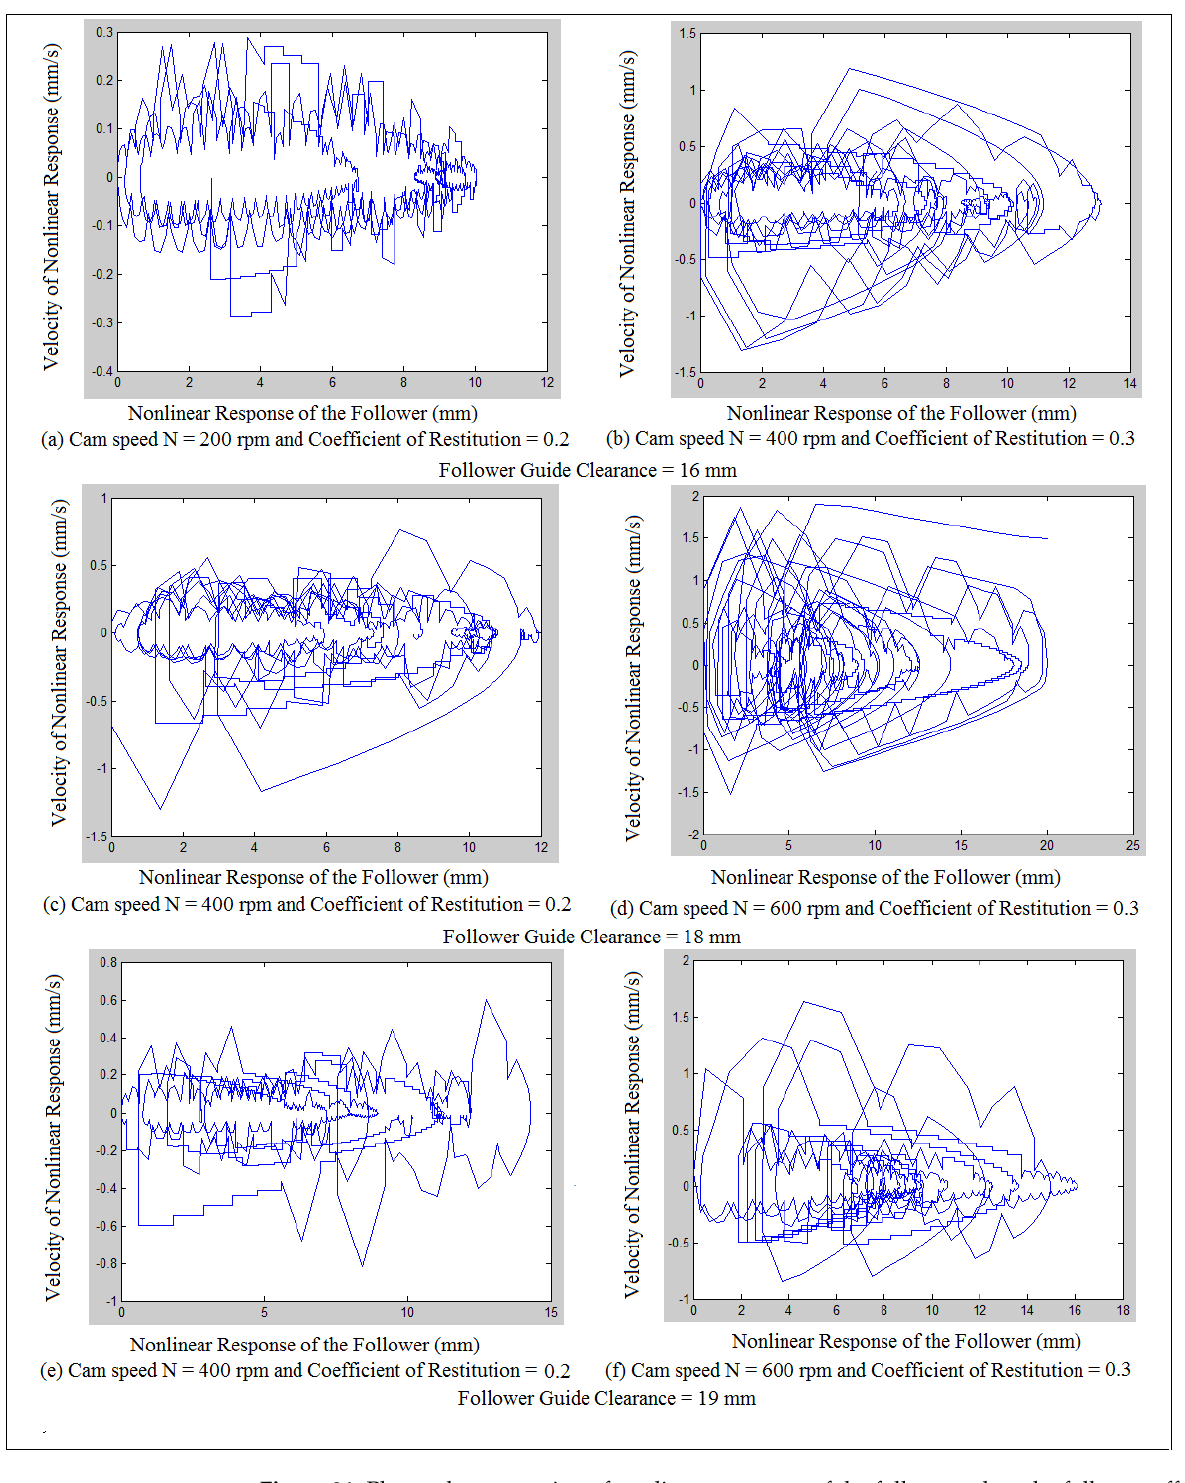
Figure 21. Phase-plane mapping of nonlinear response of the follower when the follower offsets to the left at (O = 30 mm).